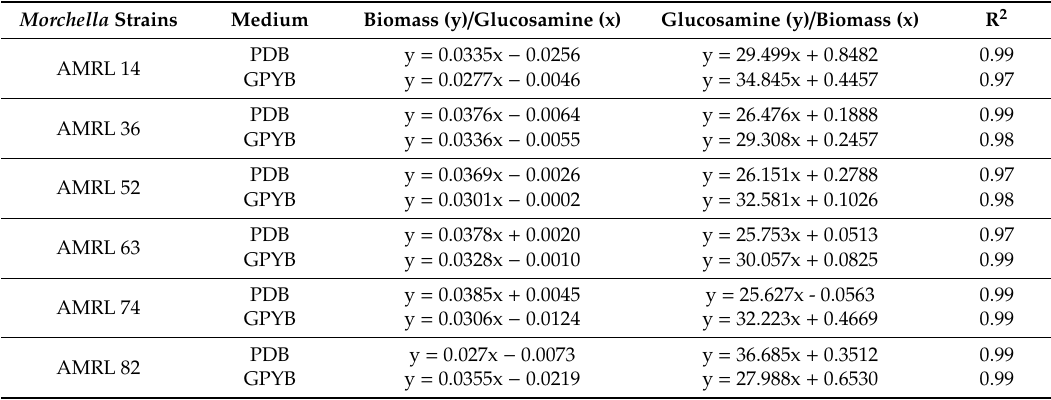
Table 3. Linear regression equations of glucosamine (mg) and mycelial biomass (g) of Morchella strains grown on potato dextrose broth (PDB) and glucose-based broth